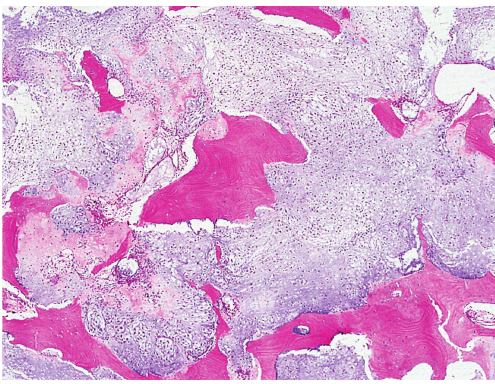
Figure 6: CHS permeating between preexisting bony trabeculae. Based on the cellularity and nuclear atypia, this lesion corresponds to grade 2 CHS.